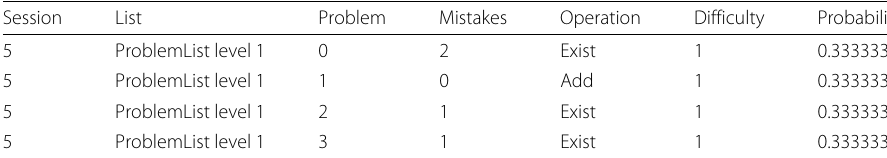
Table 1 Example of intermediary CSV generated from raw